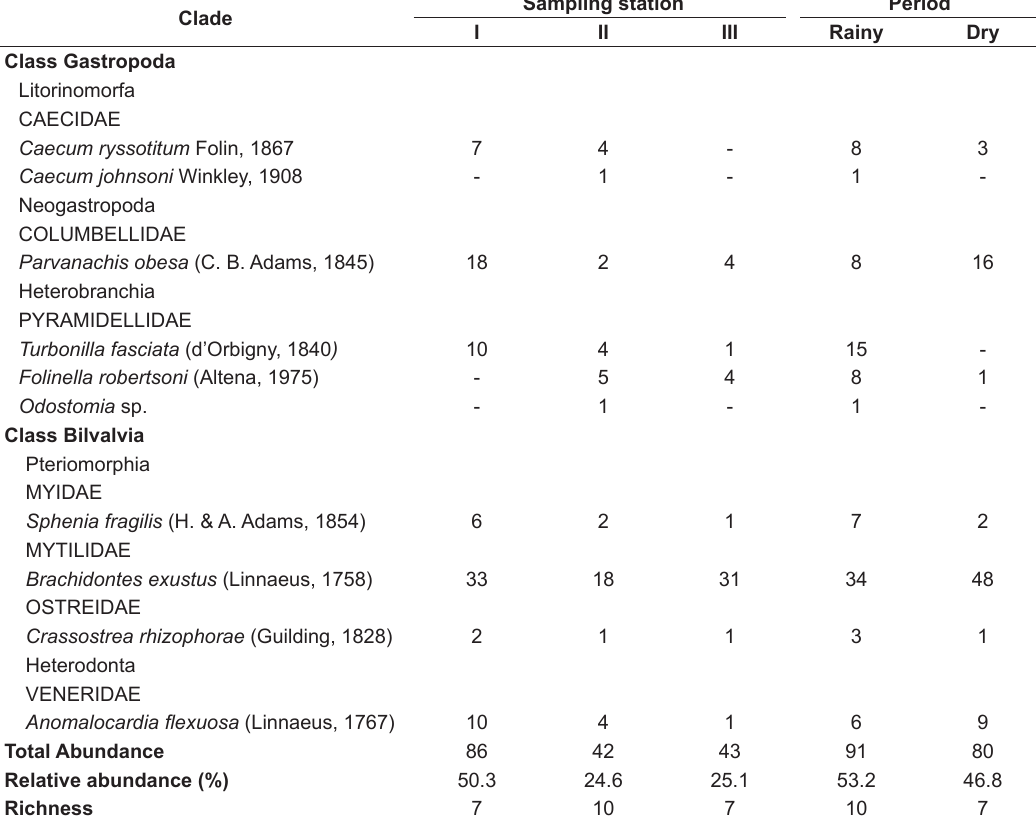
Table 1. Abundance of individuals per species in sampling stations and seasonal periods.